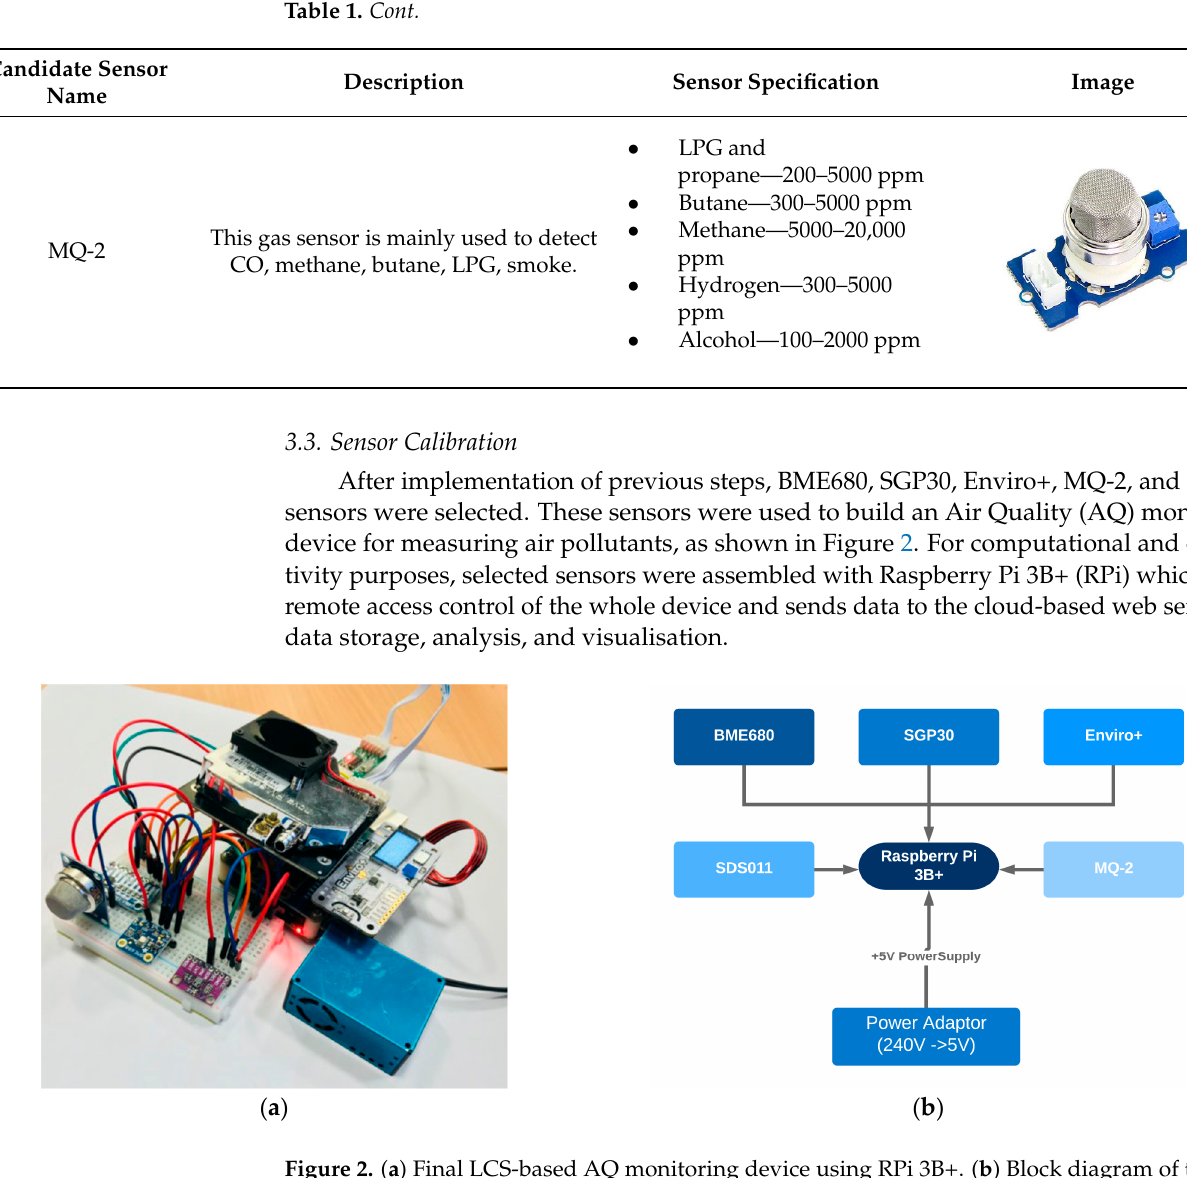
Figure 2. ( a ) Final LCS-based AQ monitoring device using RPi 3B+. ( b ) Block diagram of the final device with Raspberry Pi 3B+ and other LCS